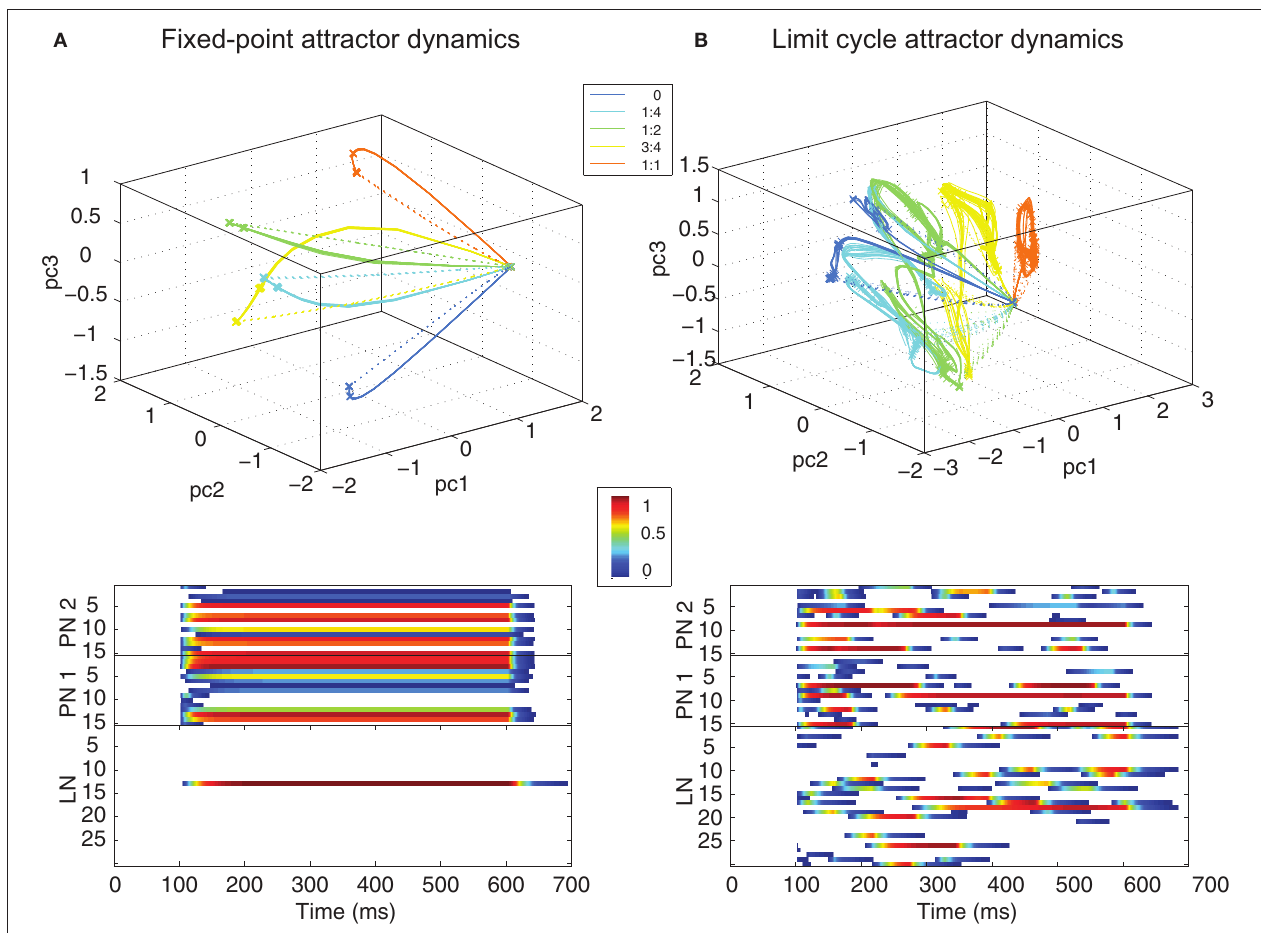
FIGURE 4 | Trajectories (top panels show 5 different ratios) and raster plots (bottom panels show ratio 1:2) of the PN population activity for different classes of dynamics observed in the MGC AL model: (A) fixed–point attractor (FPA), and (B) limit cycle attractor dynamics (LCA).